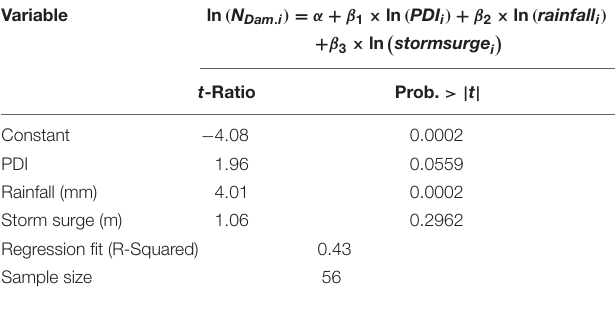
TABLE 2 | Regression results based on multivariate S-LSR for TC-related damages and different TC parameters (i.e., wind, rainfall, and storm surge).